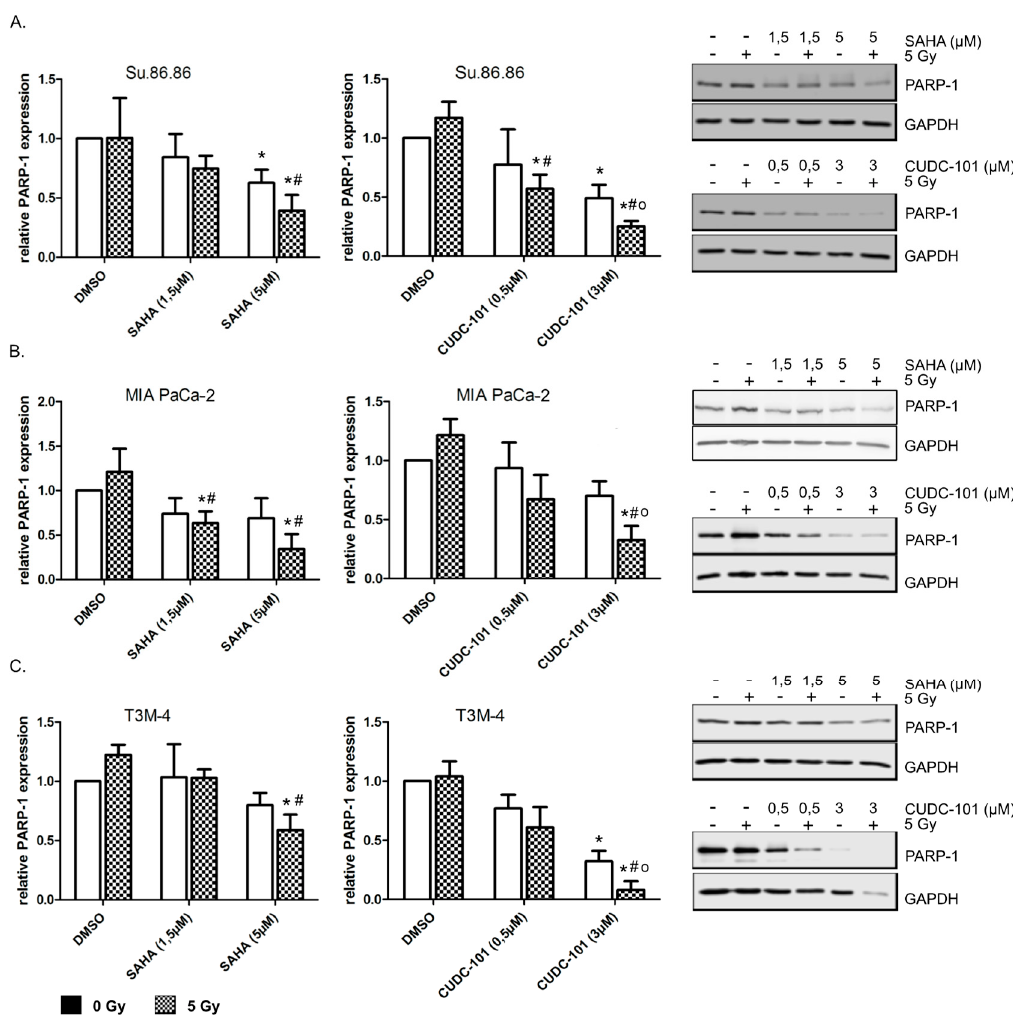
Figure 4. Radiation promoted CUDC-101 induced PARP-1 reduction. Su.86.86 ( A ), MIA PaCa-2 ( B ) and T3M-4 ( C ) cells were treated with SAHA or CUDC-101 for 24 h, then cells were irradiated with 5 Gy. 24 h after irradiation full length PARP-1 was quantified by western blot. (Left) relative PARP-1 amounts normalized to GAPDH and control amounts. Data represent the mean of at least three independent experiment ± SD. For statistical analysis ANOVA was performed with post hoc Bonferroni multiple comparisons. * Indicates comparison with DMSO control, p < 0.01, # indicates comparison with DMSO, 5 Gy, p < 0.05; o indicates comparison with CUDC-101, 0 Gy, p < 0.05. (right) representative western blots.